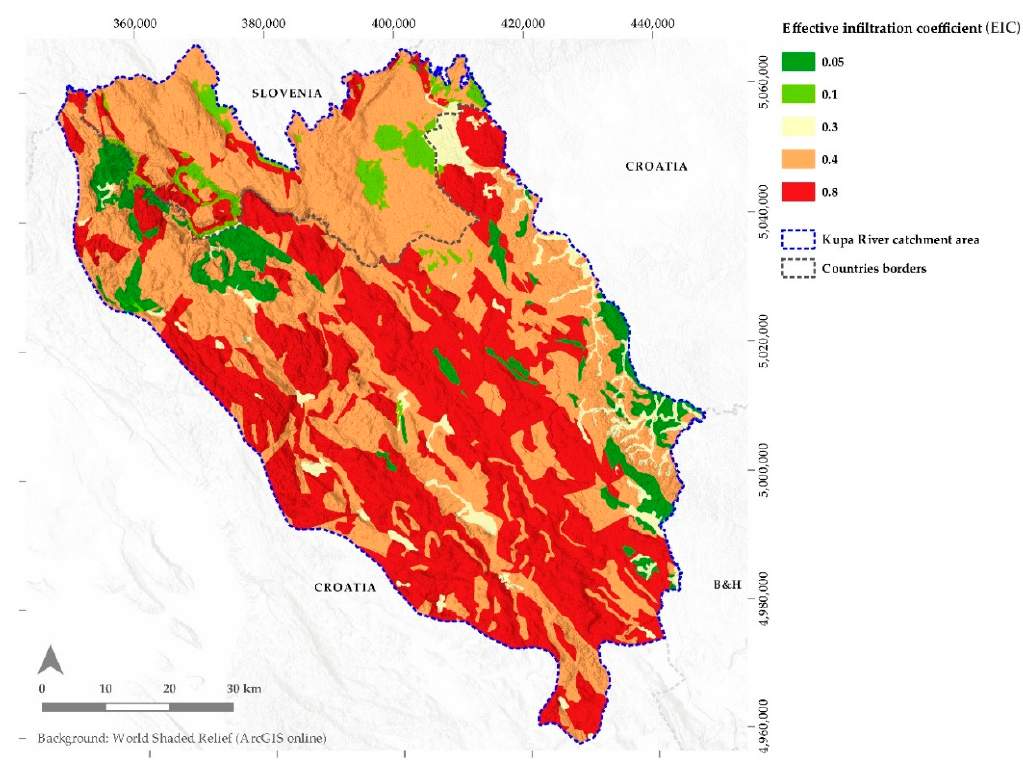
Figure 5. Effective infiltration coefficient ( EIC ). Figure 5. E ff ective infiltration coe ffi cient ( EIC